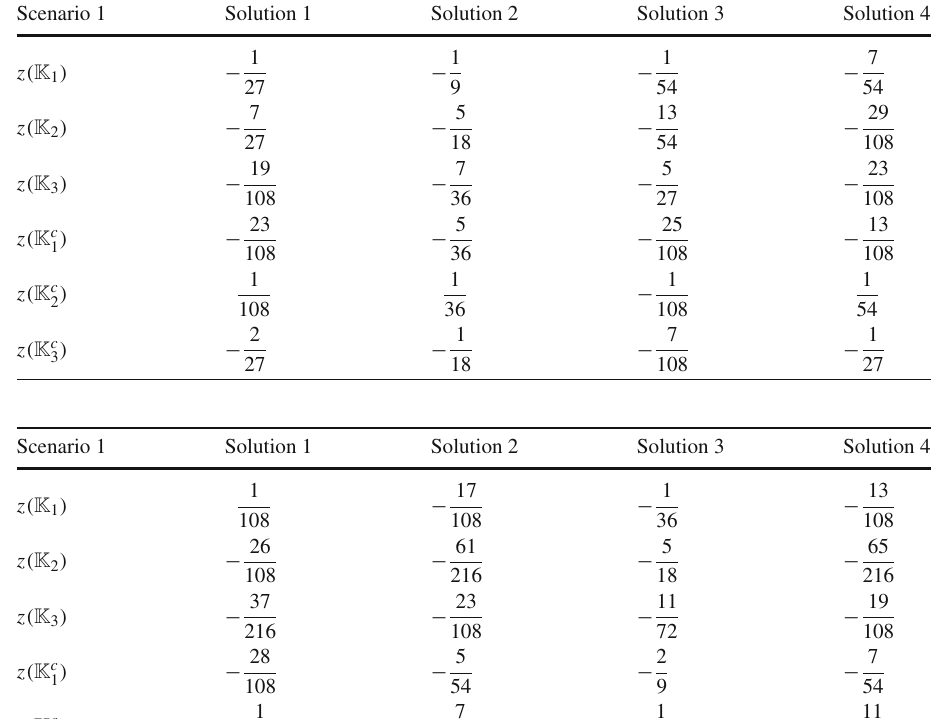
Table 7 Values of the U ( 1 ) (cid:2) charges for the exotic quarks in U μν SSM models using solution (29) with the hypercharges of Table 4. For each column, the U ( 1 ) (cid:2) charges of the rest of the fields are given in Table 2 and Scenario 2 of Table 3. The minimal number of singlets under the SM gauge group consistent with these charges is n ν c = 3 and n ξ =